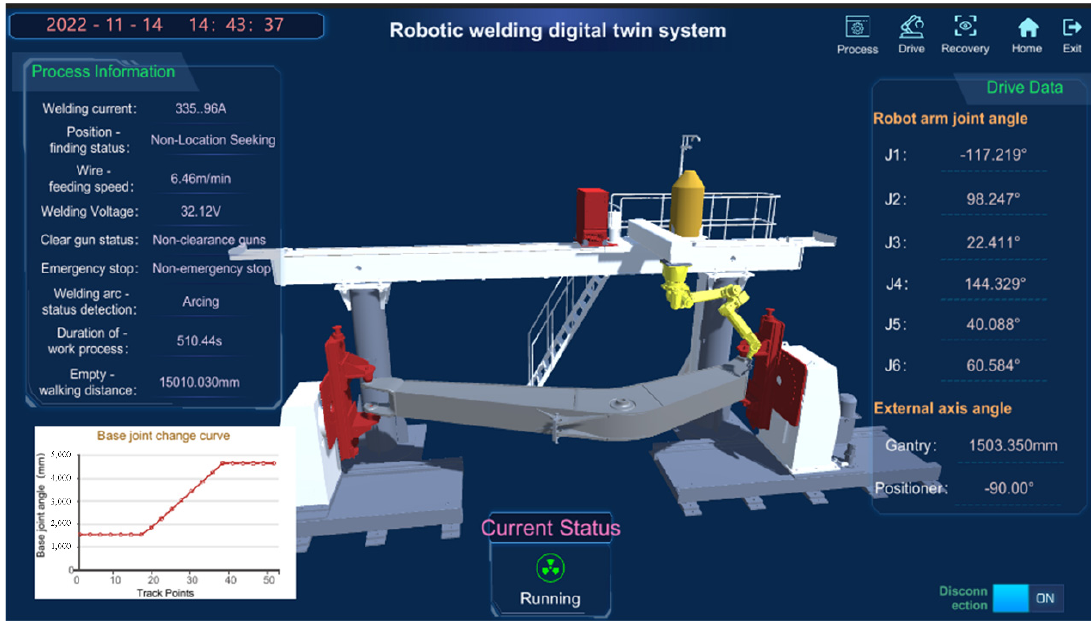
Figure 14. Physical space and virtual space virtual reality mapping. Table 5. Experimental results.